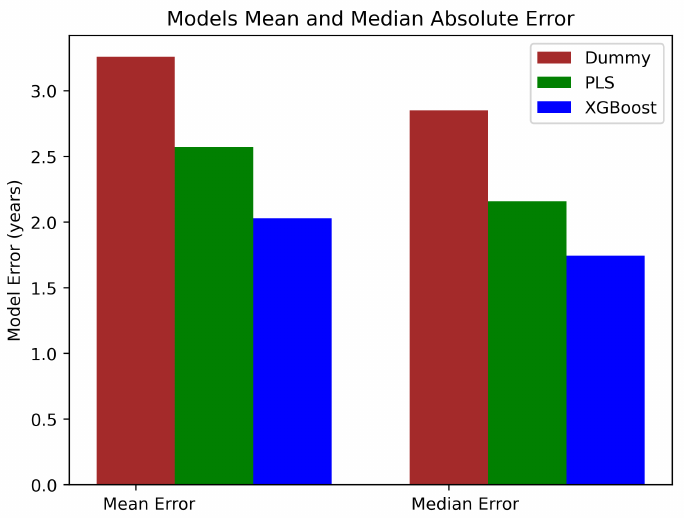
Figure 3. Mean and median absolute error for the dummy, PLS, and XGBoost models. The XGBoost model shows superior results to the